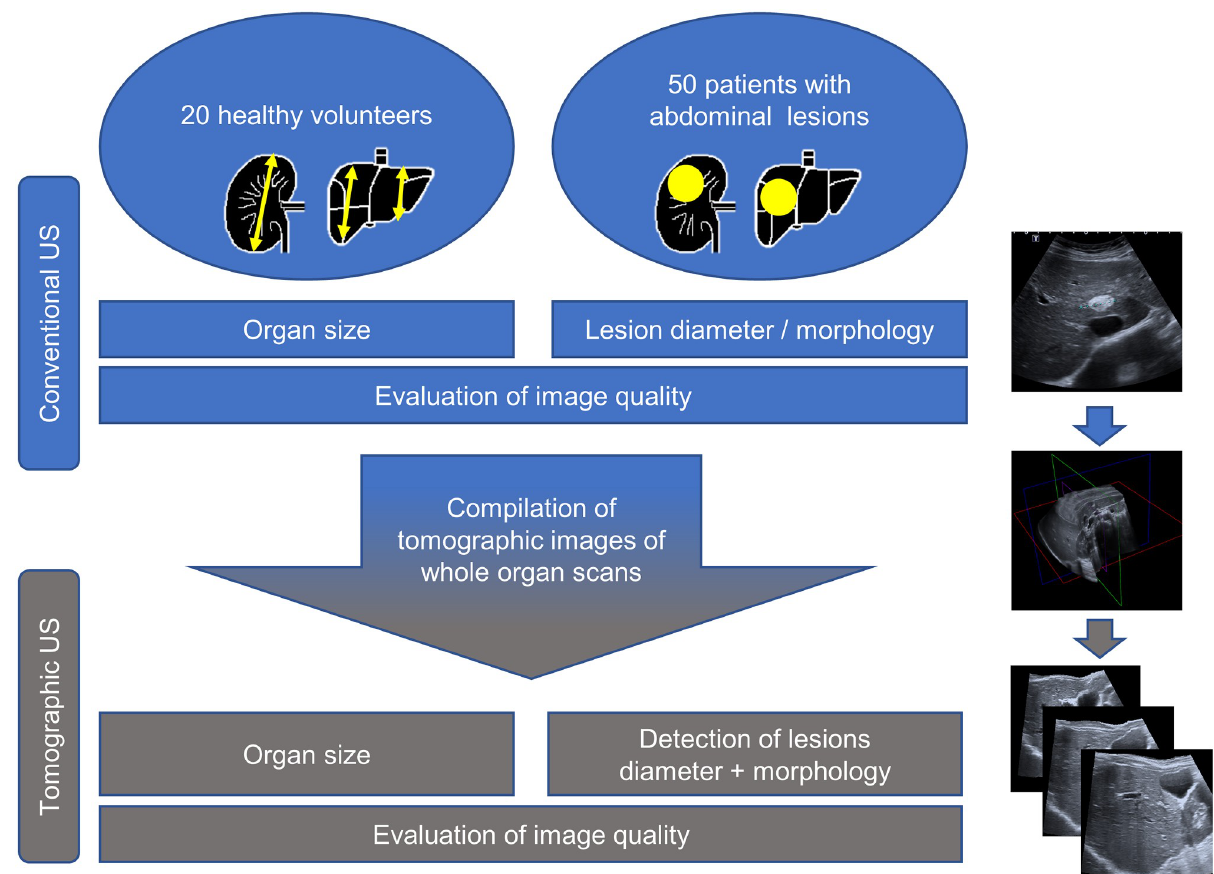
Fig 1. Overview of study